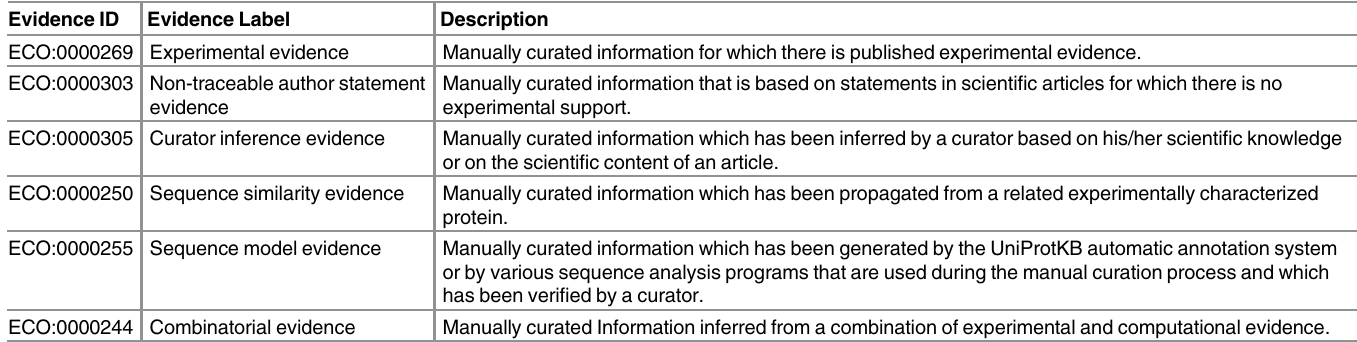
Table 2. Considered evidences for pathway annotation in